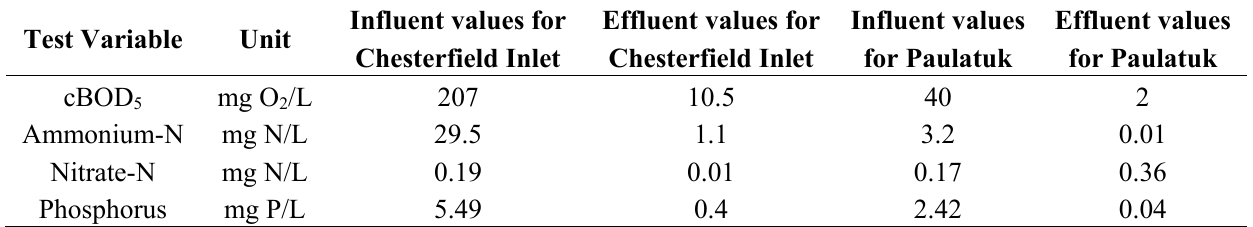
Table 2. Simulated effluent concentrations exiting the Chesterfield Inlet tundra